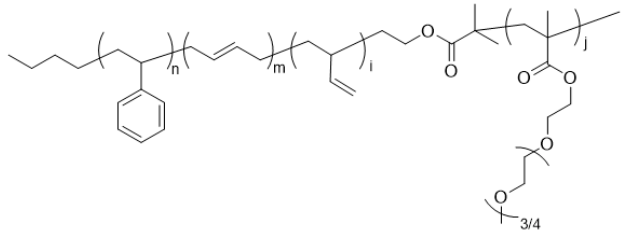
Figure 11. Structure of SBR- b -PEGMA.